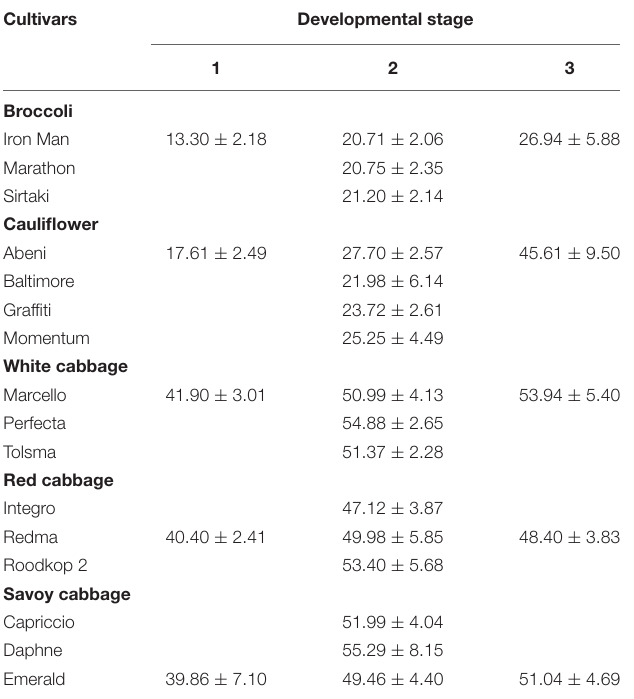
TABLE 1 | Head surface curvature diameter (cm) at harvest of three different developmental stages 1 (mini head), 2 (fully developed), and 3 (over-mature) of cultivars of five Brassica oleracea varieties.